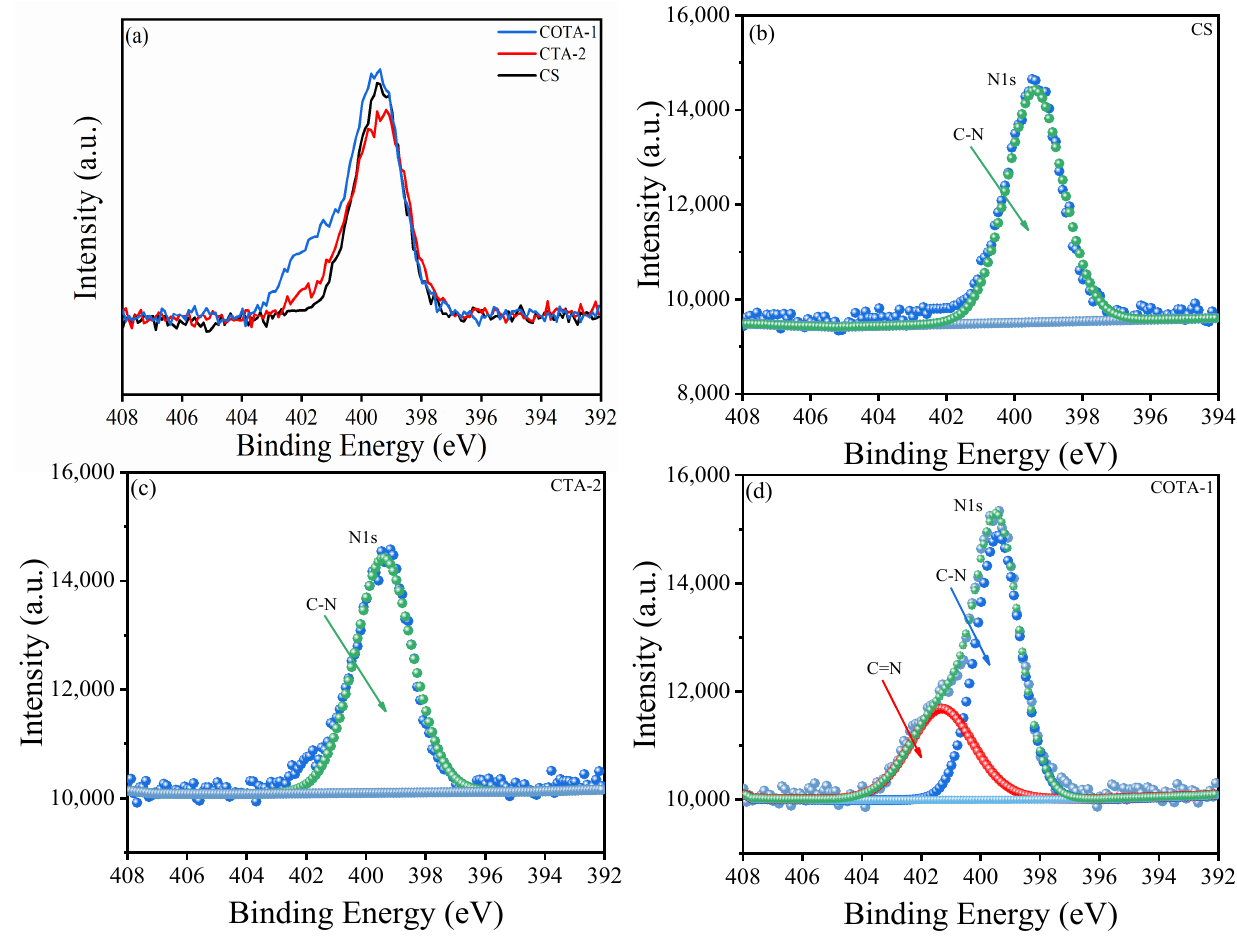
Figure 5. ( a ) N 1s spectra for the CS, CTA ‐ 2, and COTA ‐ 1 films; ( b ) N 1s region of the CS film; ( c ) N 1s region of the CTA ‐ 2 film; ( d ) N 1s region of the COTA ‐ 1 film.